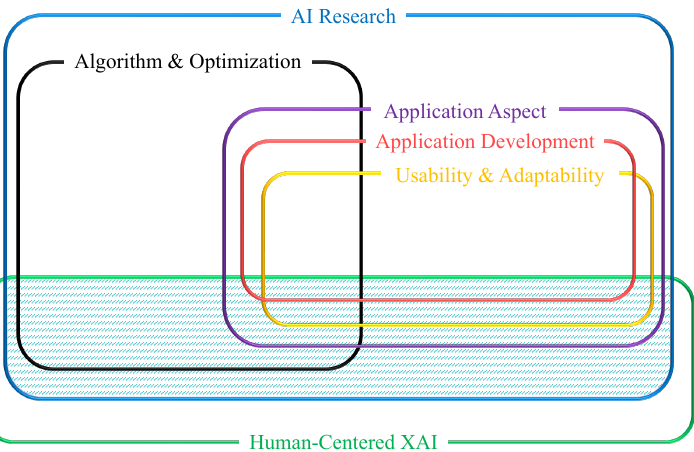
Figure 1. Human-Centered design (marked with dashed lines) research lays over a broad spectrum, as shown here. The intersection of AI Research and Human-Centered Design is the domain we identify as HCXAI